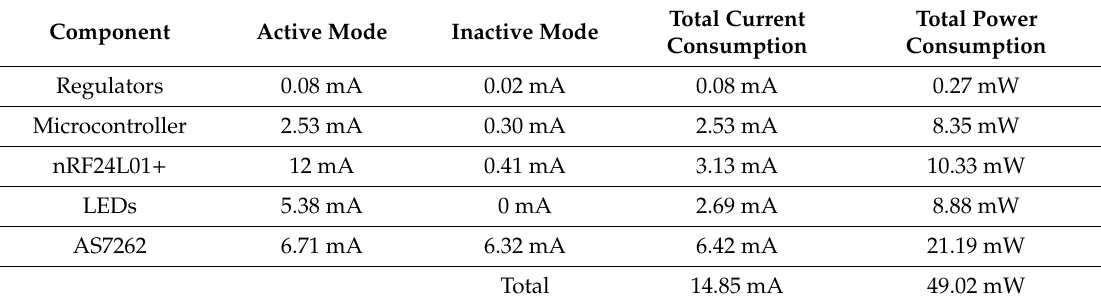
Table 2. Power consumption of the capsule prototype.